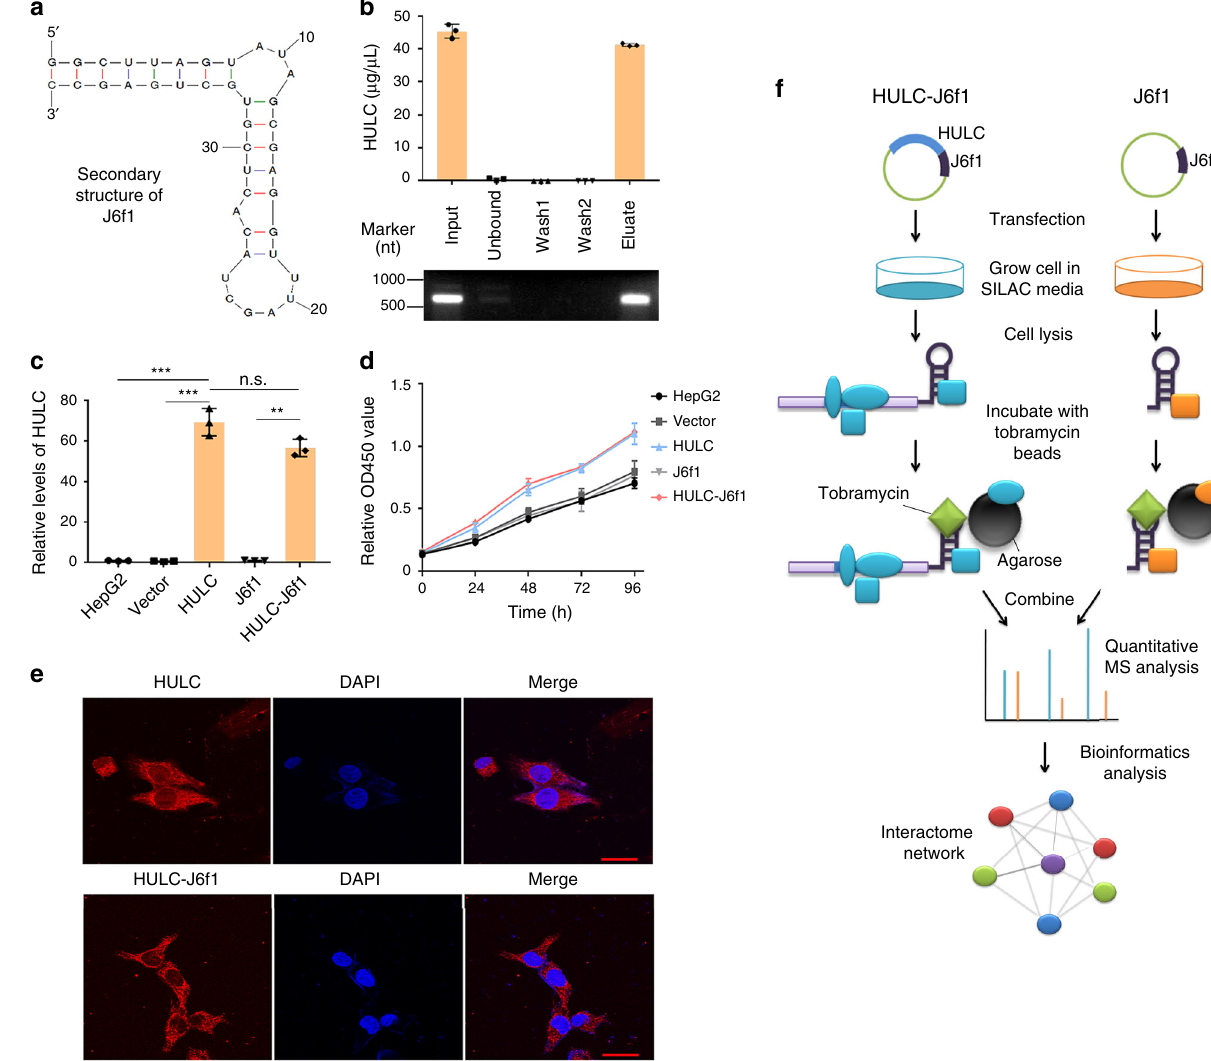
Fig. 1 The mass spectrometric strategy for characterizing HULC interacting proteins. a The secondary structure of the J6f1 aptamer predicted by MFold (http://unafold.rna.albany.edu/). b In vitro binding of HULC-J6f1 to tobramycin-conjugated agarose beads. HULC-J6f1 was synthesized by in vitro transcription. Data represent mean ± s.d. of triplicate independent analyses. c The levels of HULC in HepG2 cells overexpressing HULC or HULC-J6f1 were measured by qRT-PCR. HepG2 cells expressing empty vector or J6f1 vector were used as controls. Data represent mean ± s.d. ( n = 3 independent experiments, *** P < 0.001, n.s., not signi fi cant, by two-sided Student ’ s t test). d The proliferation of HepG2 cells expressing HULC or HULC-J6f1 was measured by CCK8 assay at the indicated time points. Data represent mean ± s.d. of triplicate independent experiments. e The cellular localizations of HULC and HULC-J6f1 were analyzed by RNA-FISH. The scale bar was 20 μ m. f The work fl ow of tobramycin af fi nity puri fi cation mass spectrometry (TOBAP-MS). See also Supplementary Fig. 1. Source data are provided as a Source data fi